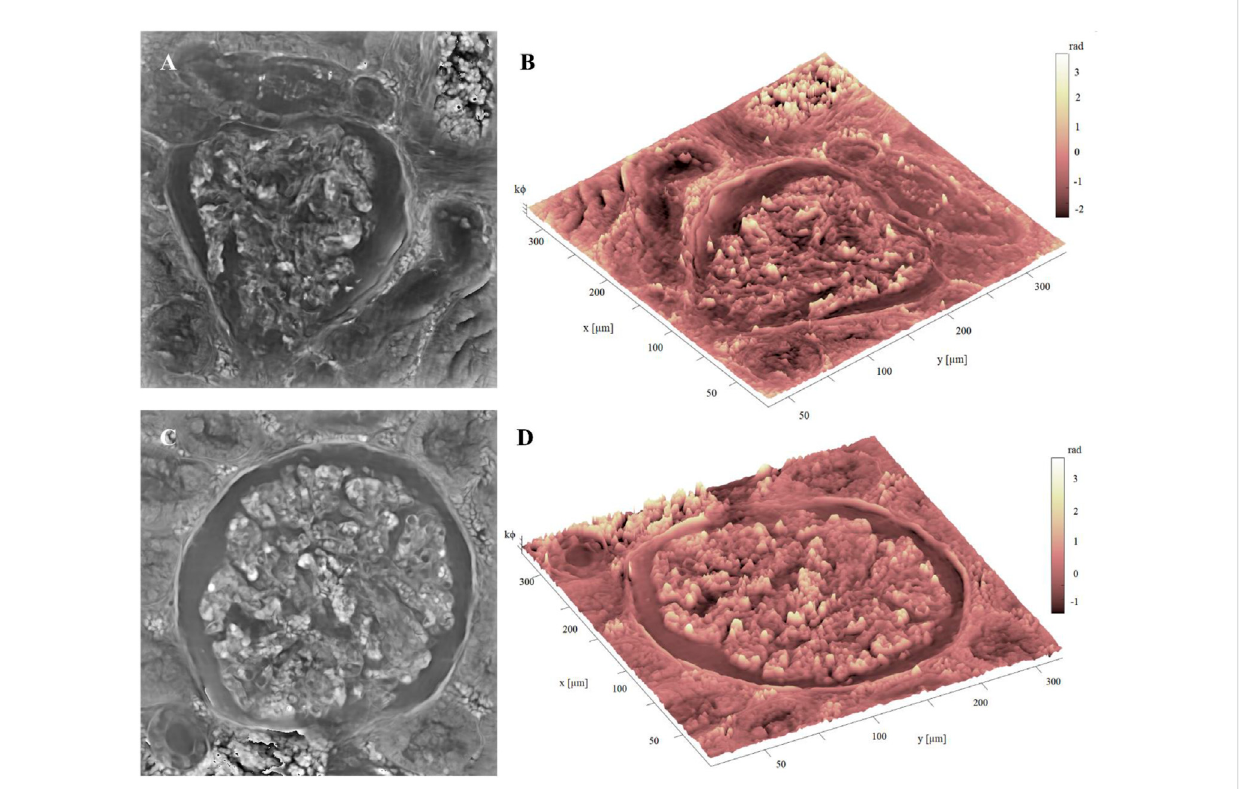
FIGURE 6 Unstained glomerulus details: (A) FP phase map of unstained glomerulus, captured by FP, 10 µm thick; (B) Pseudo3D plot of the glomerulus in (A) , whose axes represent the real dimensions of the samples; (C) FP phase map of a different unstained glomerulus, captured by FP, 10 µm thick; (D) pseudo3D plotoftheglomerulus in (C) .The color-barrepresentsthephasevaluesinradiants,multiplied byak constant equal to10 forthesakeofbetter